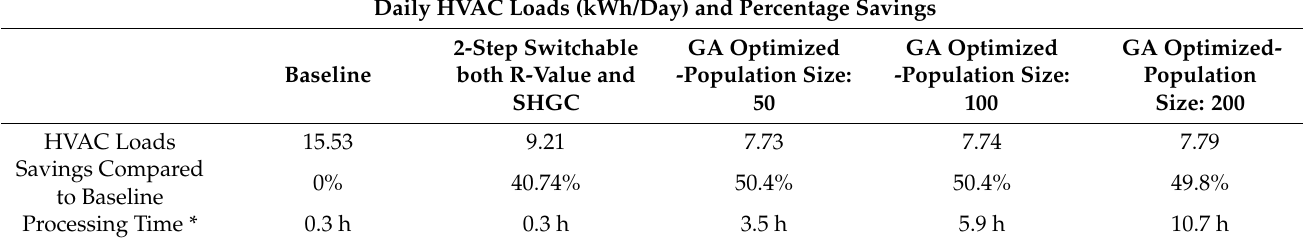
Table 13. Impact of population size on GA optimization results for STIS–smart windows applied to a house located in Golden, CO, during 21 May.